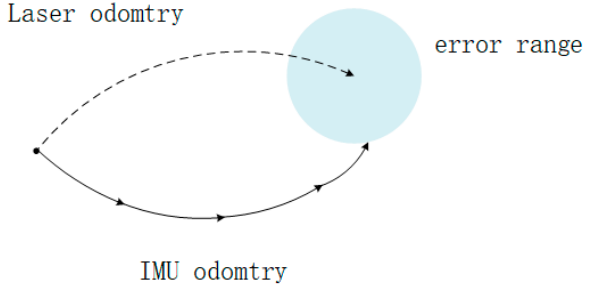
Figure 9. The error range in ceres solver.